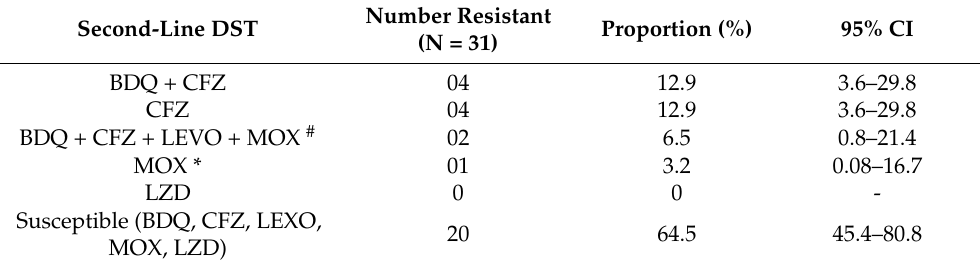
Table 3. Proportions of DR to second-line anti-TB drugs among first-line drug-resistant patients.